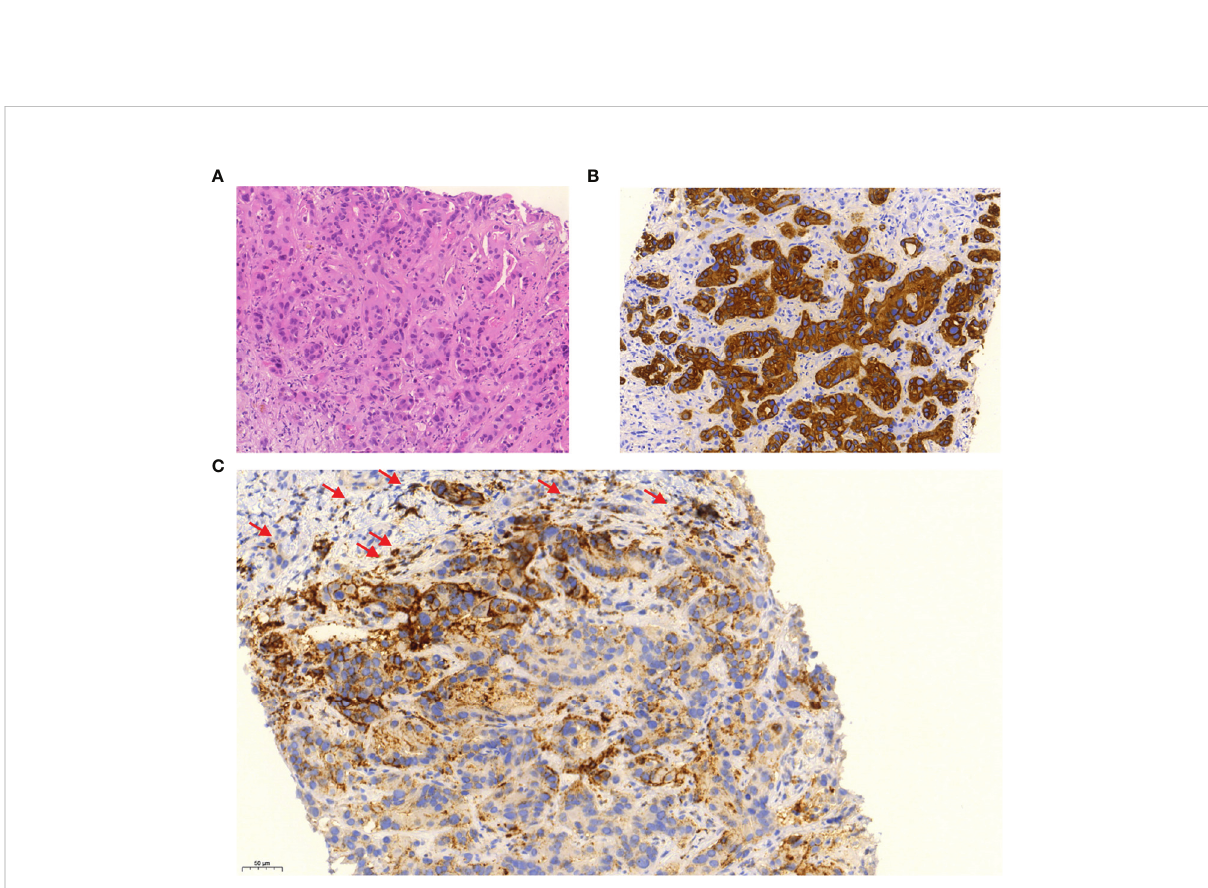
FIGURE 3 Liver biopsy (×20 magni fi cation) of second hepatic metastasis in February 2020 shows in fi ltrates of atypical glandular proliferates in hematoxylin and eosin staining (A) , which were positive for CK7 (B) . Immunohistochemistry staining shows weak to moderate membranous expression of PDL1 in about 50% of the tumor cells and in about 20% of surrounding immune cells (C)